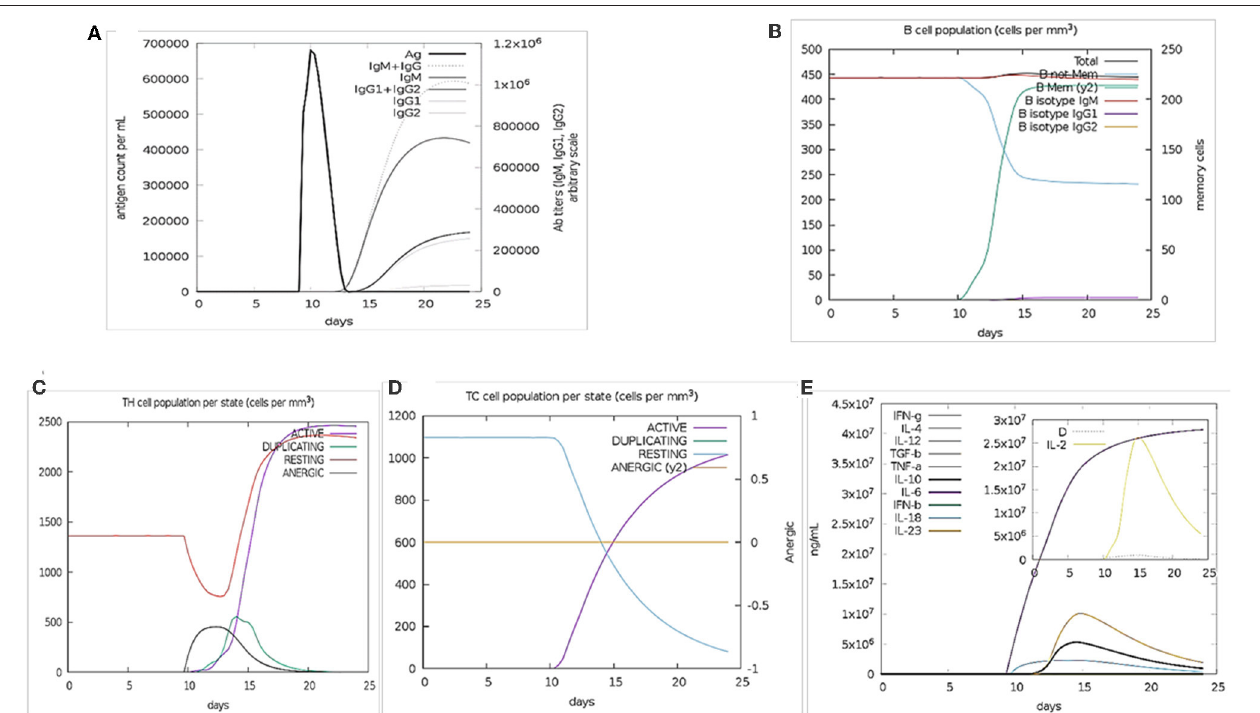
FIGURE 2 | Immune Simulation results by C-ImmSim. (A) The immunoglobulins production represent proliferation of immune response after the vaccine administration. Various subtypes of immunoglobulin are represented as colored peaks. (B) The active B-cell population is observed with the administration of vaccine. (C) The generation of Helper-T cells. (D) The generation of cyototoxic-T cells were found after the vaccine injection. The RESTING indicates to the cells, which were not shown to the antigens while ANERGIC indicates the tolerance level of antigen. (E) The cytokine profile shows that the induced IFN- γ level upon administration of vaccine. The inset graph indicating the Simpson Index, D of IL- 2. Simpson Index, D was inferred as the measurement of diversity.